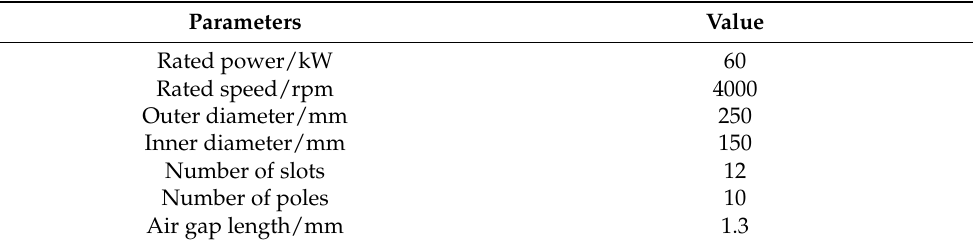
Table 1. Key parameters of the YASA